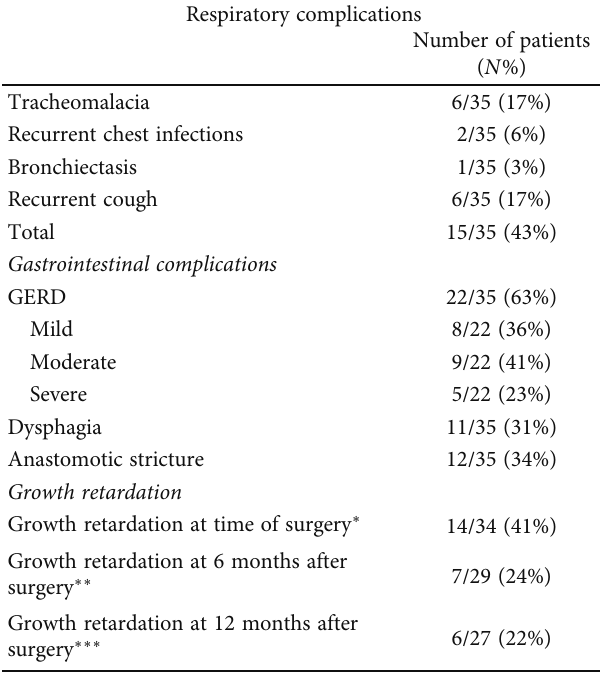
Table 5: Long-term complications of TEF (some patients have multiple